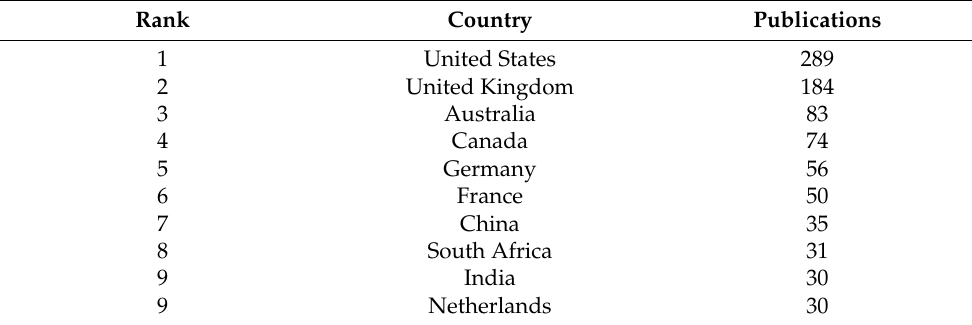
Table 2. Top 10 countries by the number of publications.